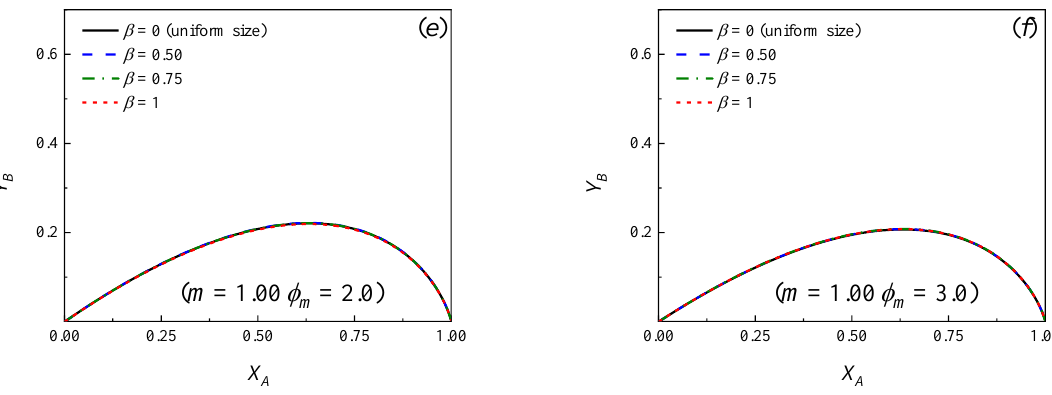
Figure 3. Yield of primary product B as a function of the conversion of the reactant A for different values of the dispersion parameter ( β ). m = k 2 / k 1 = 1.00. ( a ) ϕ m = 0.1; ( b ) ϕ m = 0.2; ( c ) ϕ m = 0.3; ( d ) ϕ m = 1.0; ( e ) ϕ m = 2.0; ( f ) ϕ m = 3.0.